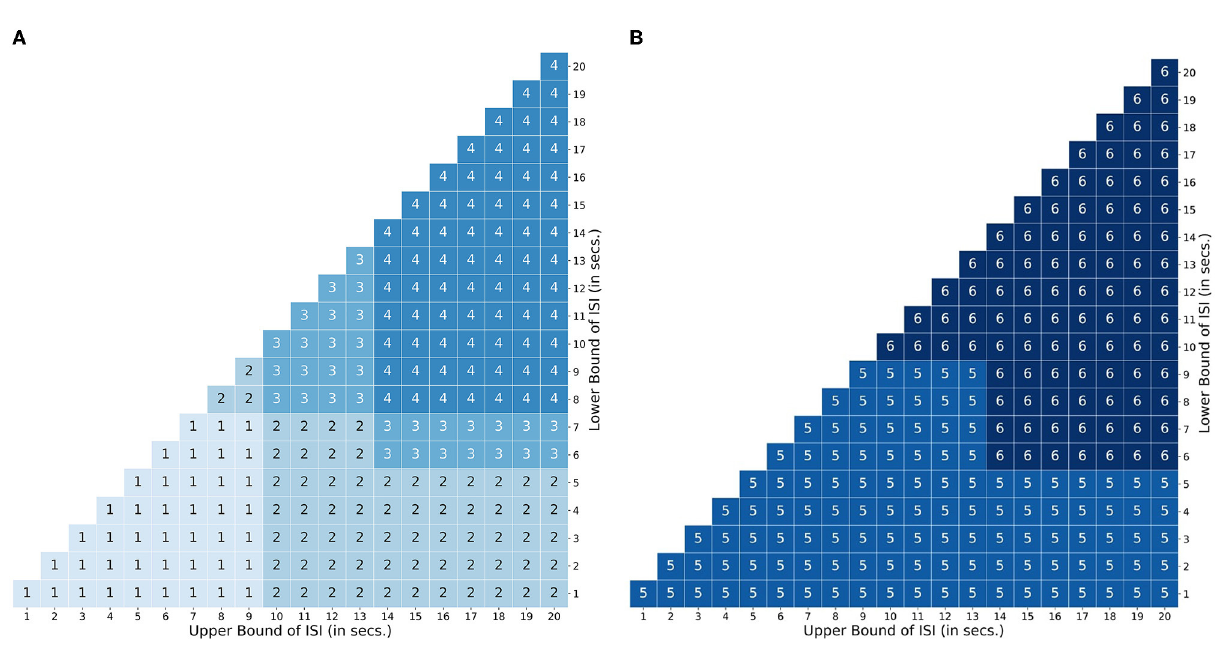
FIGURE5 Transient Temporal Maps (TTPs). TTP map encompassing the space defined by the bounds of the inter stimulus interval. (A) Usage map of profiles 1 - 4 designed for an attentional control paradigm. (B) Usage map of profiles 5 and 6 for a working memory